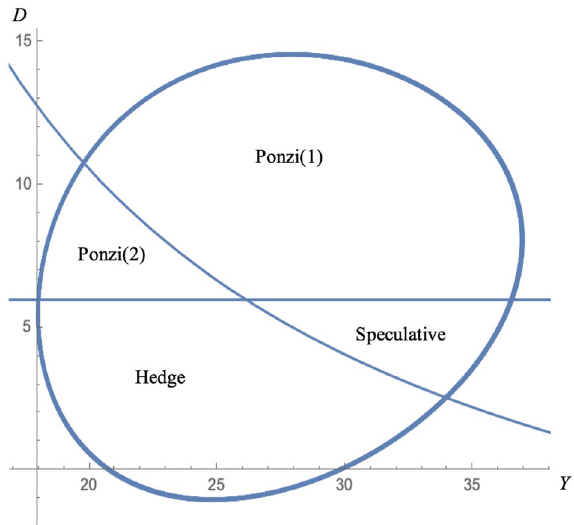
Fig. 5 Numerical simulation system S